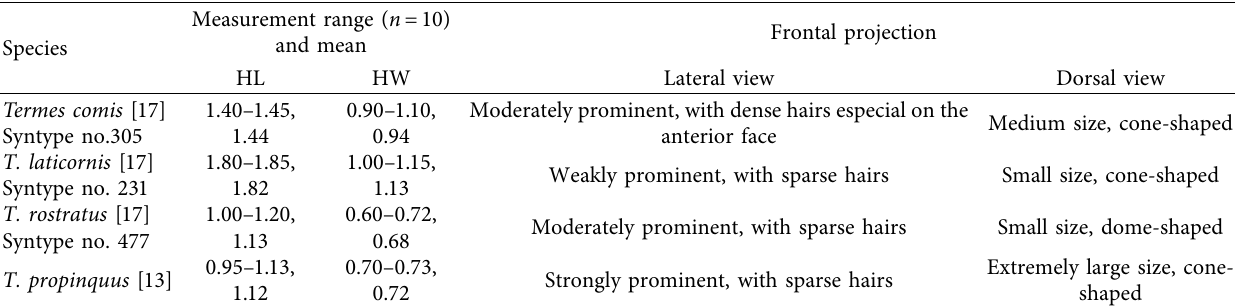
Table 2: Morphological comparison among four Termes species known from Sumatra and adjacent